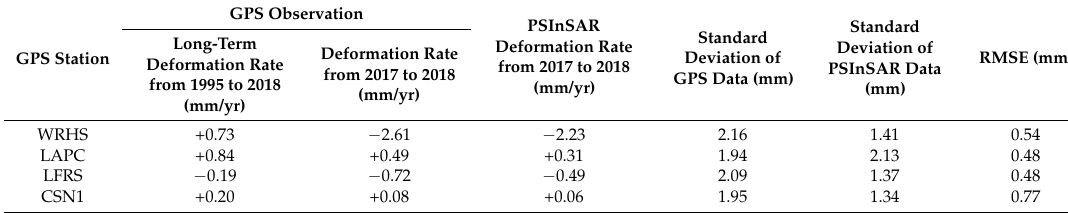
Table 2. The comparison between GPS and PSInSAR